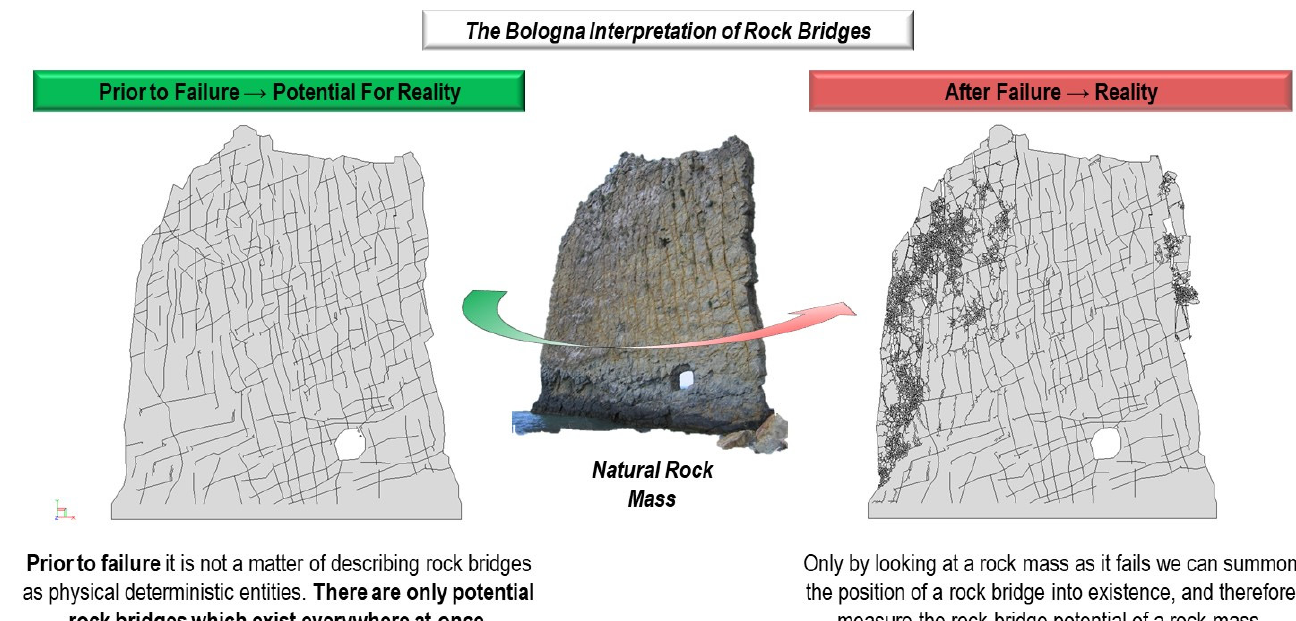
Figure 8. Illustration of the Bologna Interpretation of rock bridges, showing that rock bridges could only be defined and therefore measured post ‐ failure.